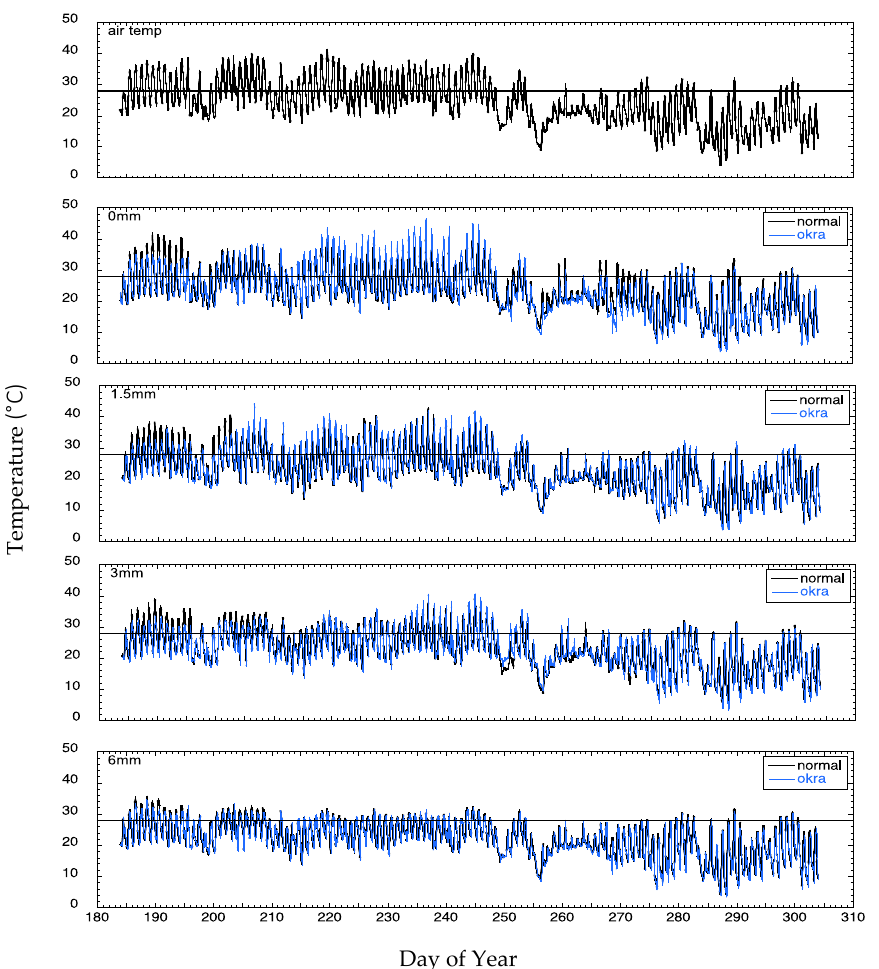
Figure 2. Pattern of air and canopy temperatures measured in the field for 120 days for okra and normal leaf varieties. The horizontal line indicates the 28 °C, the putative optimal cotton canopy temperature.